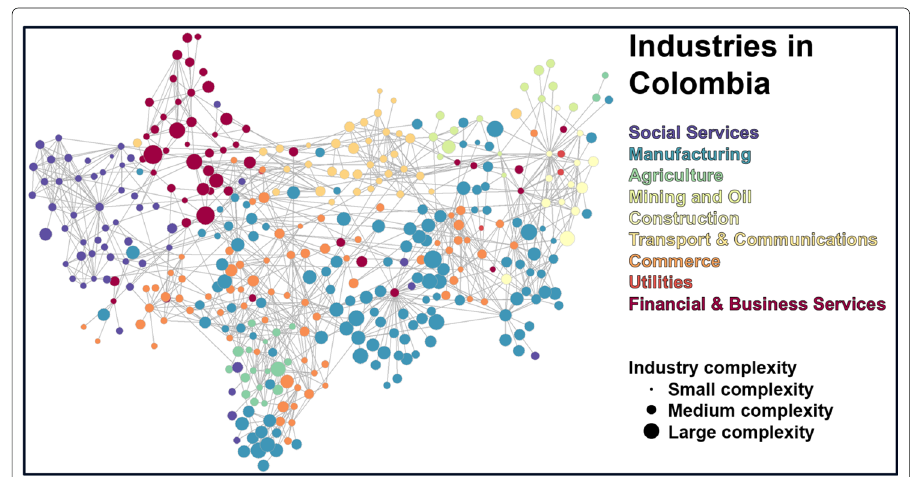
Fig. 6 Visualisation of the skill-relatedness network for Colombia, where nodes correspond to industries and edges correspond to positive values of the adjacency matrix given in Eq. 2. The node size is proportional to industry complexity, and colours correspond to the sector groups given in the legend